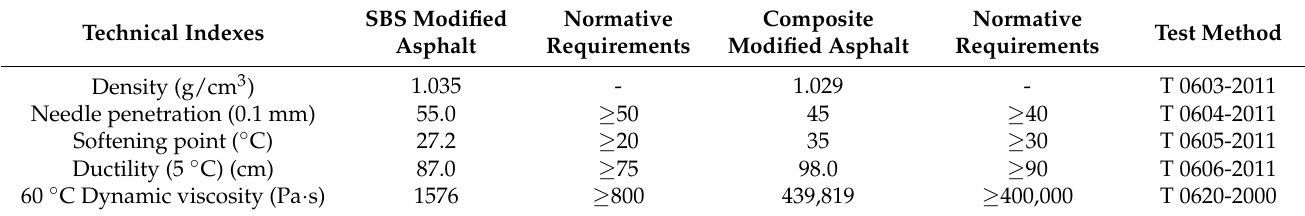
Table 3. Technical indexes of the modified